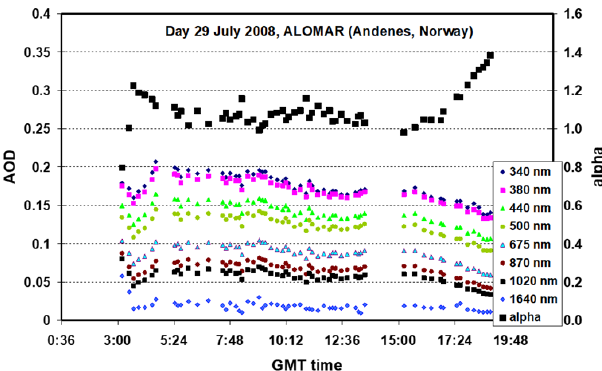
Figure 12. Time evolution of AOD at different wavelengths and alpha parameter on 29 July 2008 at Andenes (Andøya, Norway).